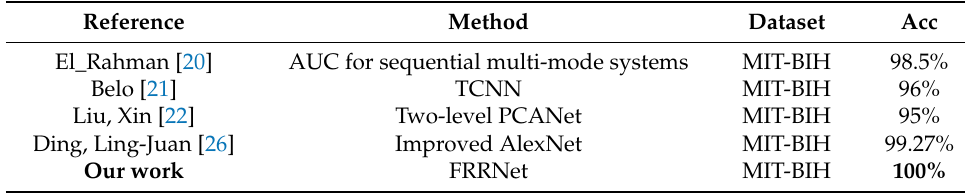
Table 6. Comparison of the proposed model with other methods.